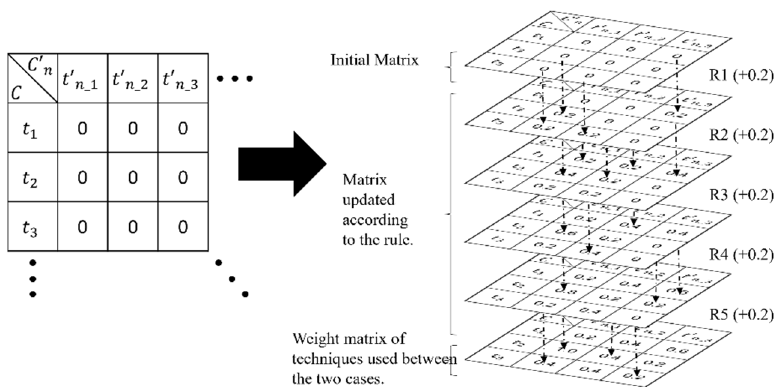
Figure 5. Assigning weights and updating matrices according to the rules.